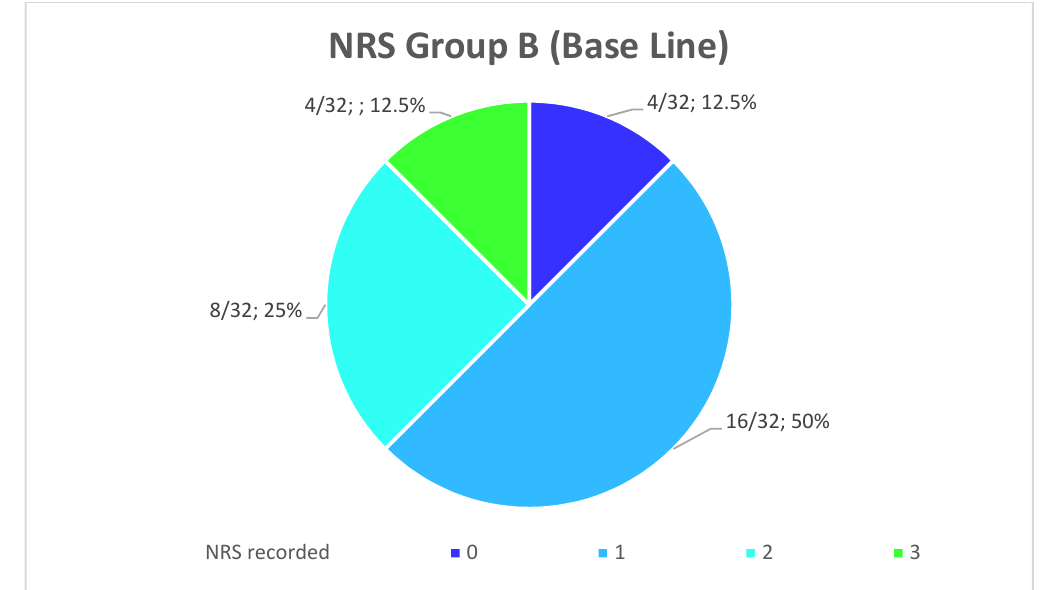
Figure 12. Distribution (numerical and percentage) of the NRS recorded in patients of Group B immediately after surgery.